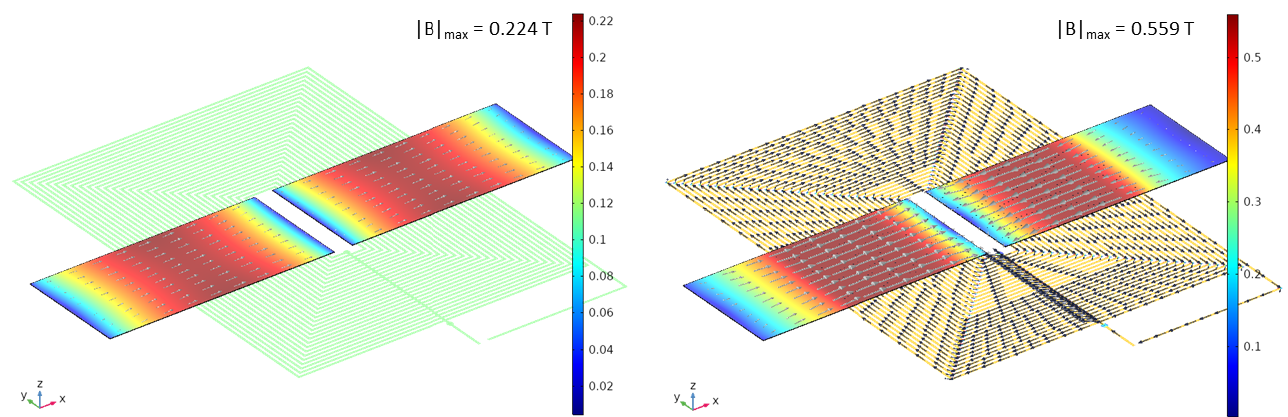
Figure 10. Contour-plot of the magnetic field norm on the cores with gray arrows indicating the field direction, together with contour-plot of the current density norm on the excitation coil with black arrows indicating the current direction, at t = 0 s ( left ) and t = 25 µ s ( right ) corresponding to zero and the peak current, respectively, for a 150 µ T external field. Color bars in T.